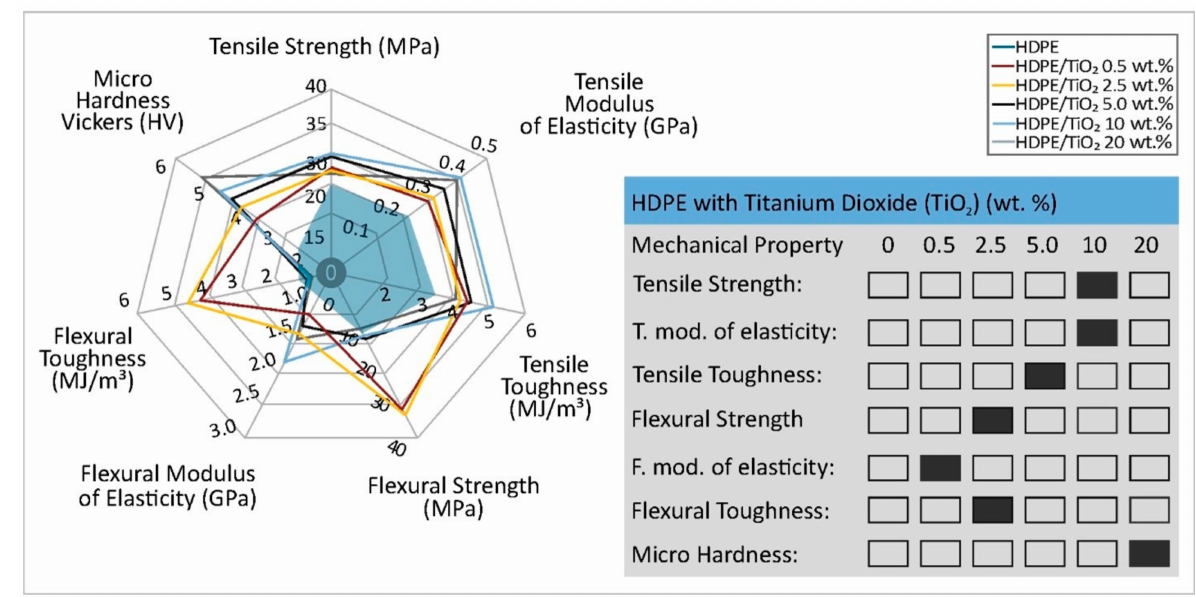
Figure 11. Overall mechanical properties results for HDPE with TiO 2 as